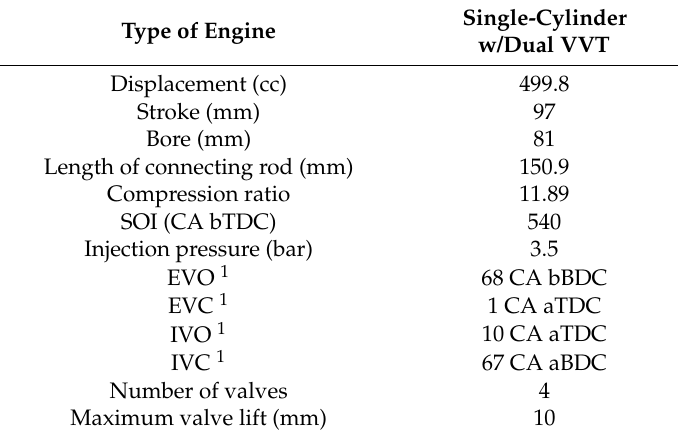
Table 2. Detailed engine